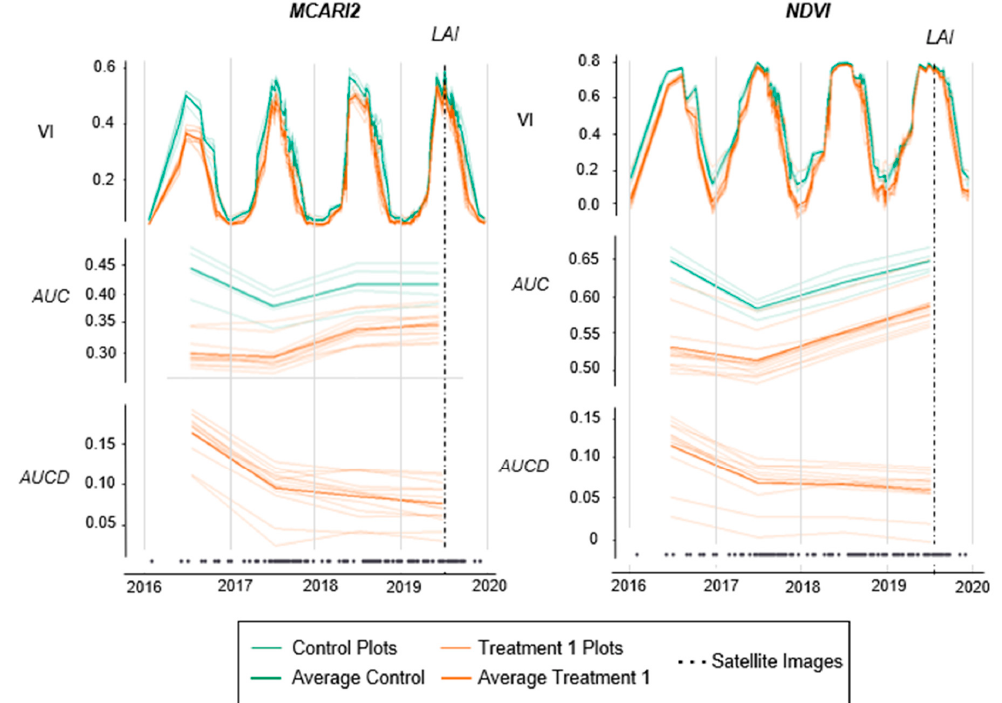
Figure 8. Evolution of the values for MCARI2 and NDVI with all of the valid S2 images available from 2016 to 2019 Trial 2. Areas under the annual VI curves ( AUC ) and differences in AUC between control and treatment plots ( AUCD ) for the same time series. LAI refers to when fieldwork was carried out.